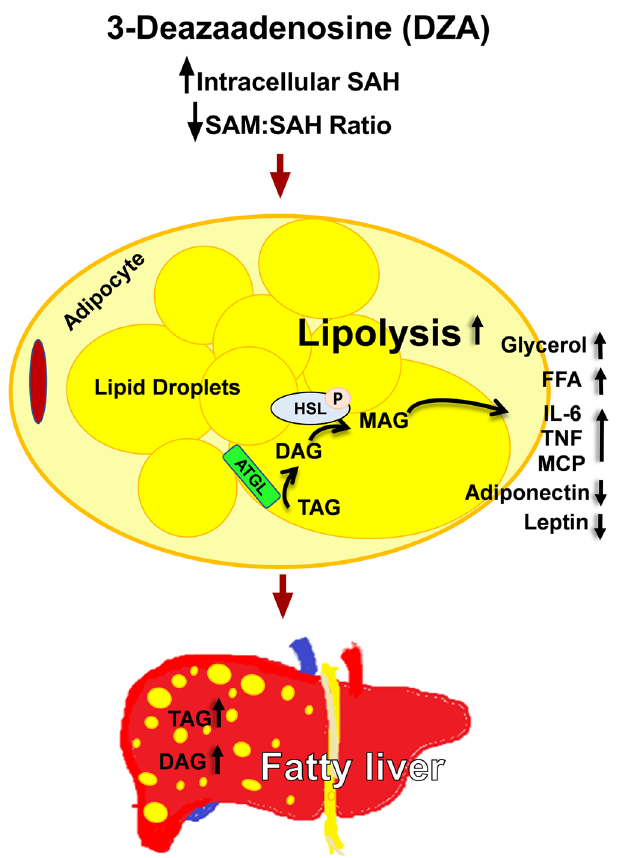
circulating FFAs and pro-inflammatory cytokines while decreasing protective adipokine release.